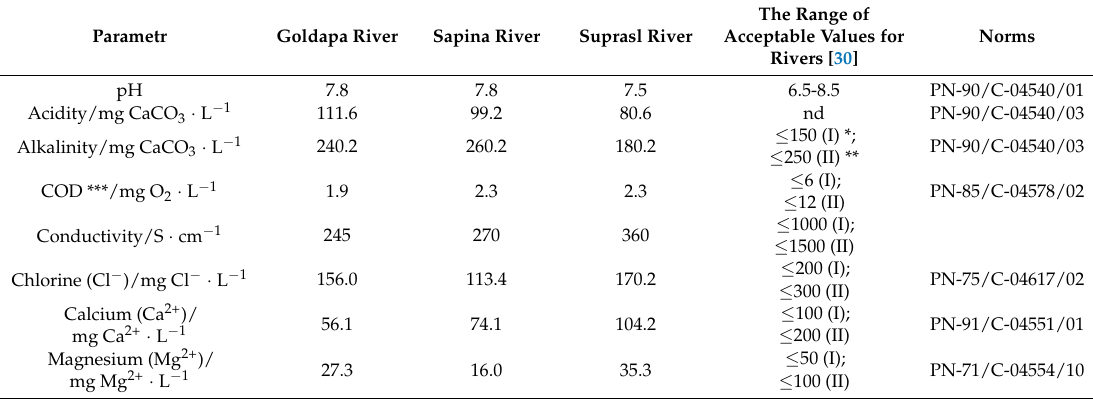
Figure 12. Efficiencies ( η ) of PhOH ( a ) and MB ( b ) photocatalytic degradation in the presence of TiO 2 or TiO 2 / 3 , and the following matrices: MilliQ water, Goldapa, Sapina, and Suprasl river waters, wastewater effluent, and municipal wastewater. Table 2. River water parameters.